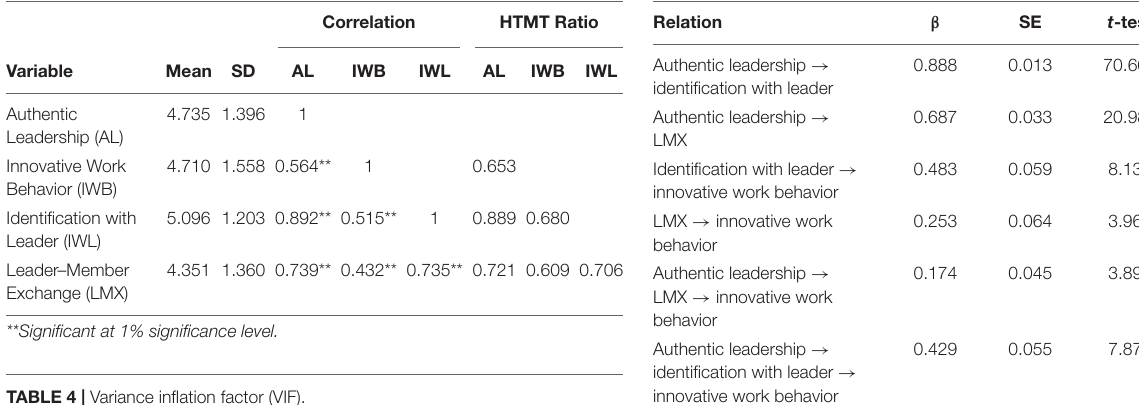
TABLE 5 | Structural